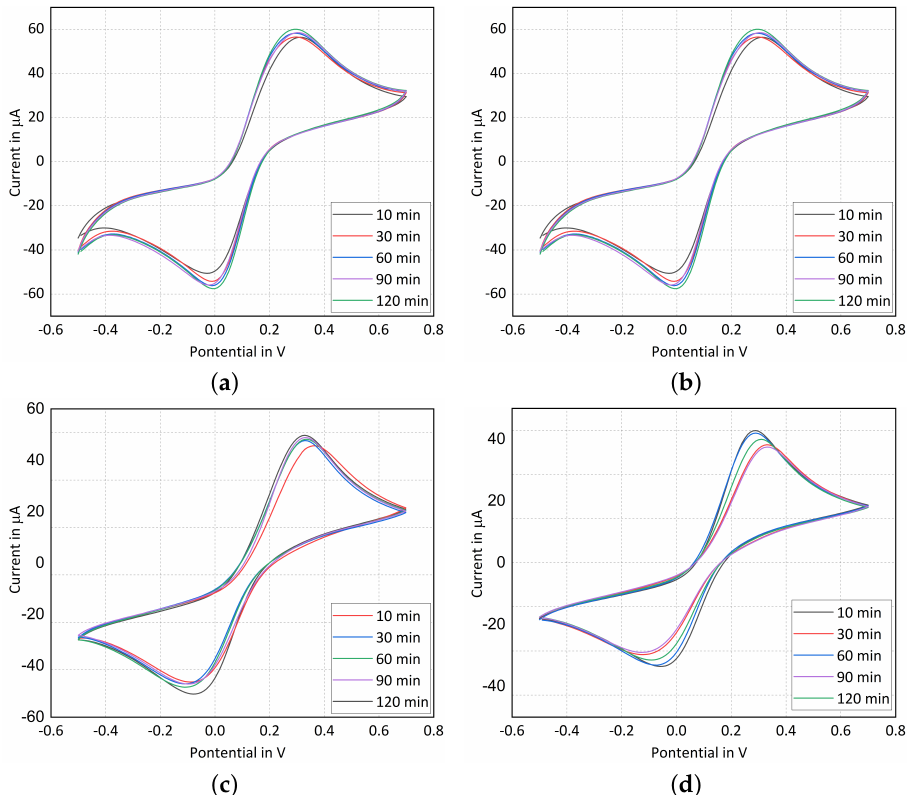
Figure 9. Cyclic voltammetric of fMWCNT dispersion in solvents at different sonication time.